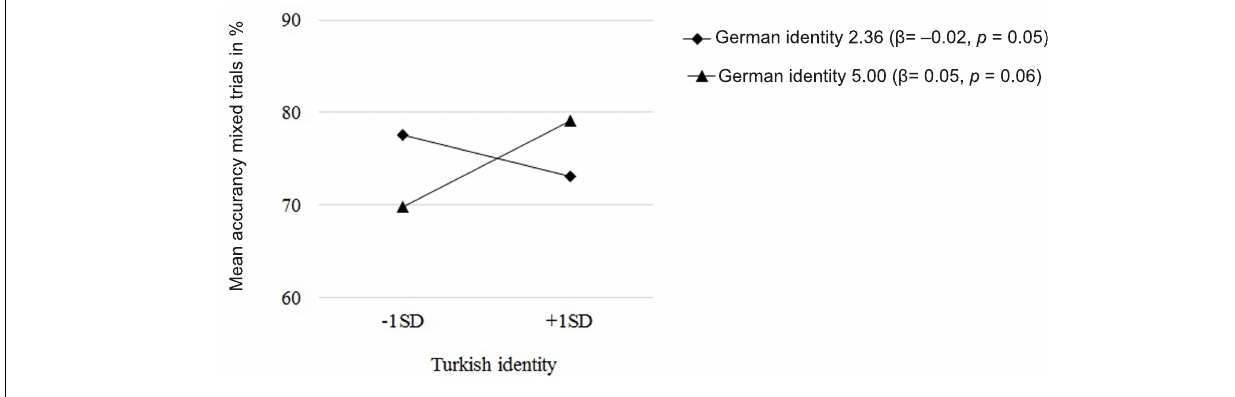
FIGURE 1 | Turkish and German identity interactively predict cognitive